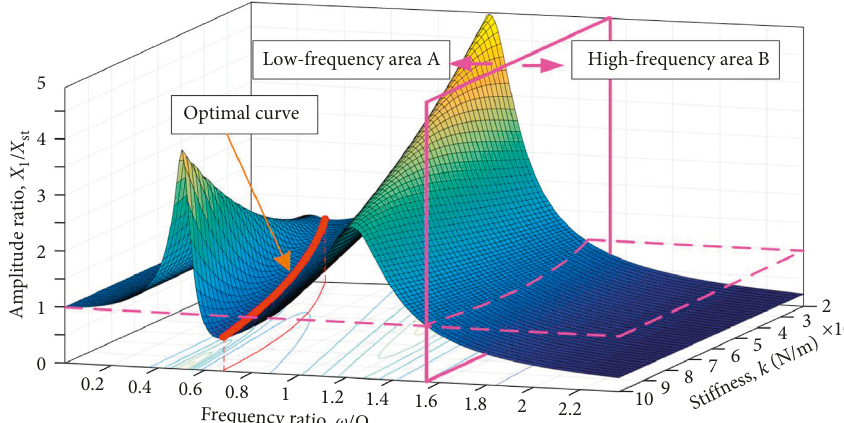
Figure 9: Three-dimensional surface of the amplitude ratio under the influence of the coupling of the frequency ratio and stiffness.